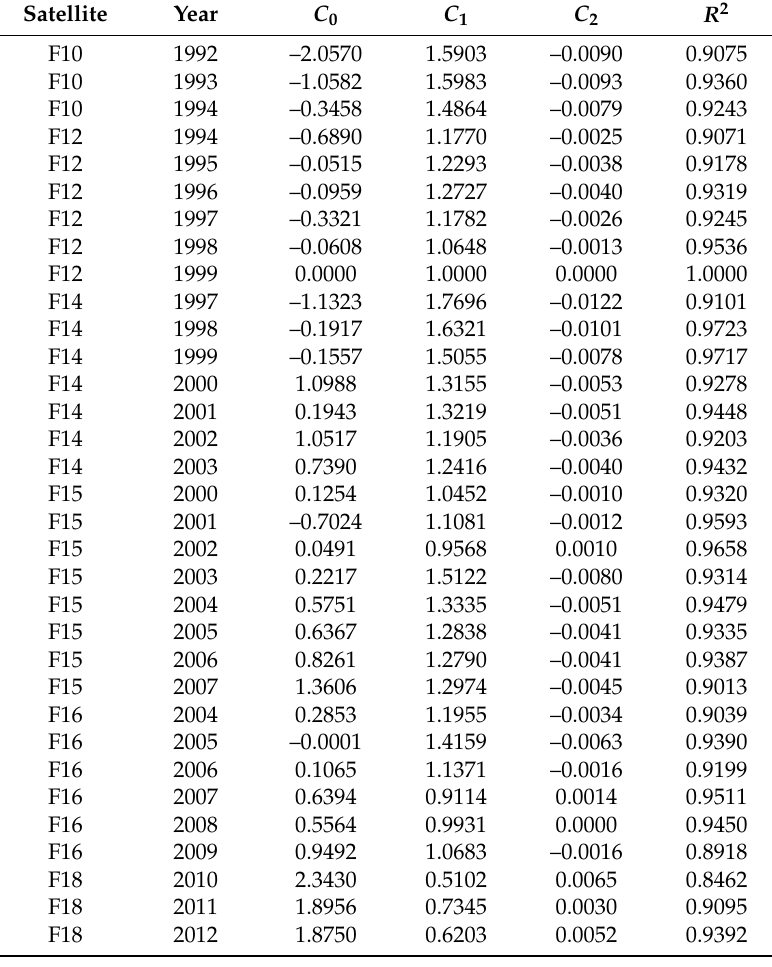
Table 1. Inter-calibration coefficients of